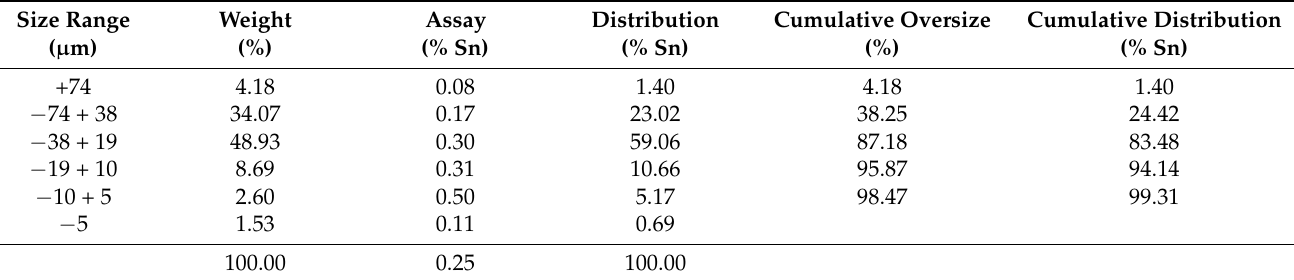
Table 1. Size analysis results of actual ore